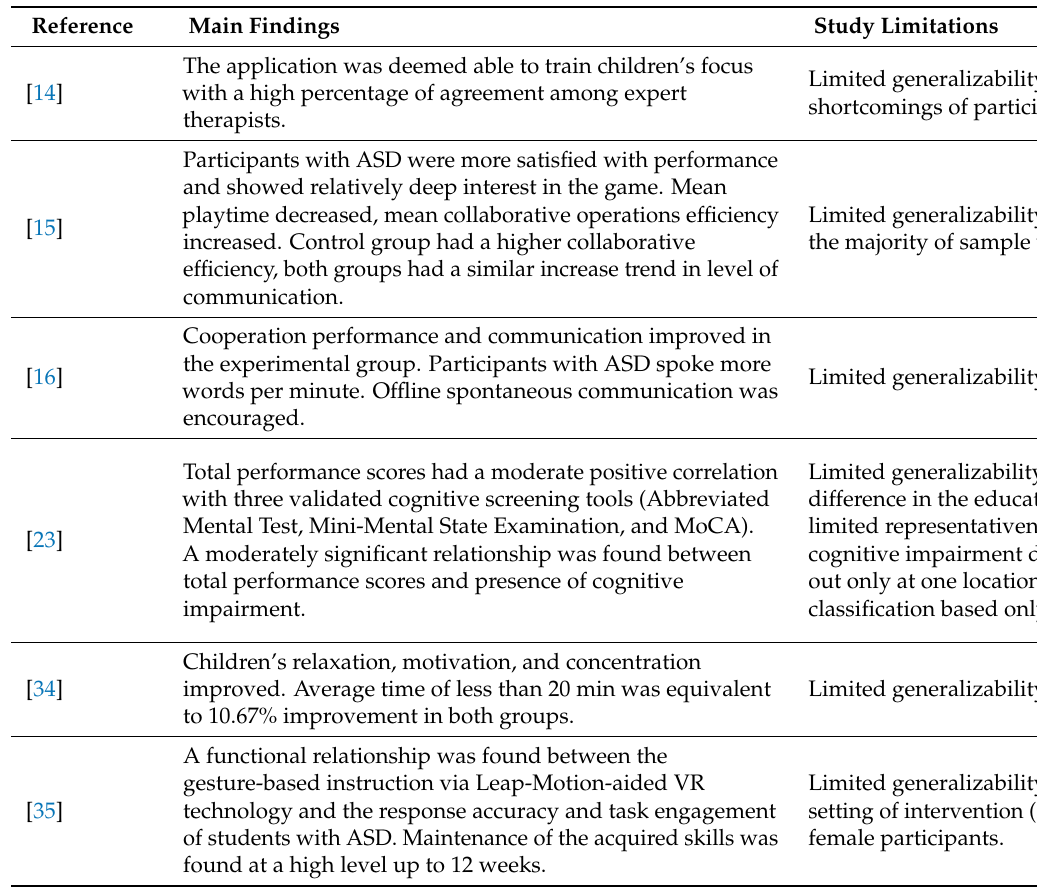
Table A2. Main characteristics of the studies reviewed: main findings, study limitations, risk of biases ( n =